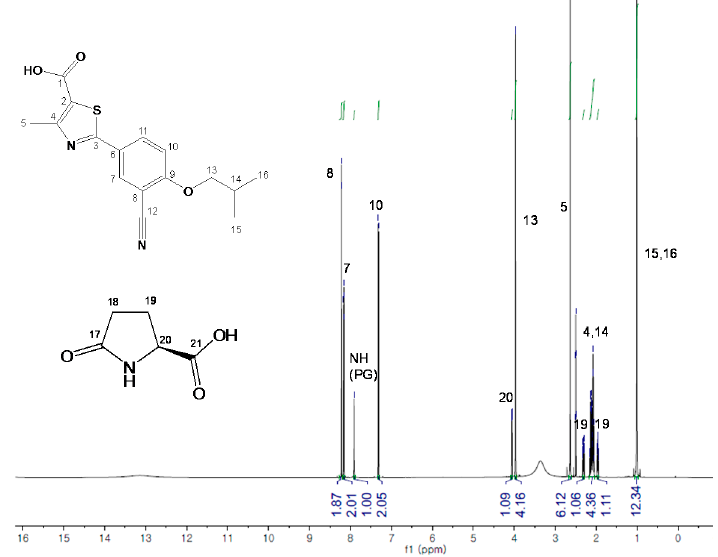
Figure 7. Integration of solution-state 1 H-NMR spectrum of FB-PG cocrystal (DMSO- d 6 ).